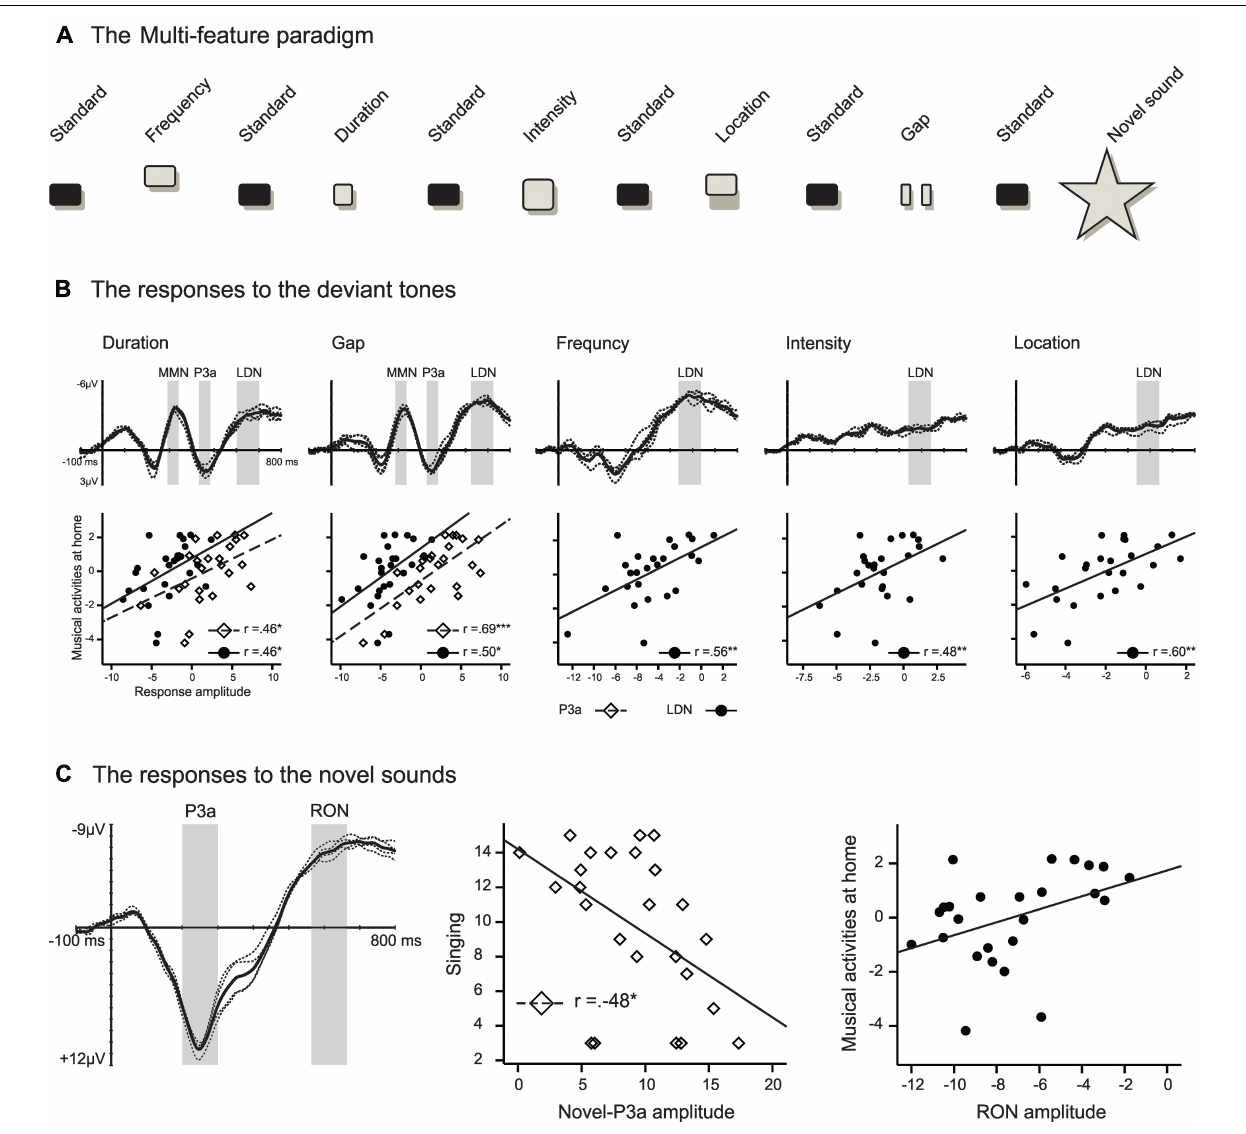
amplitudes and informal everyday musical activities. In the ERP figures, the thin dashed lines represent the difference signal at individual fronto-central channels and the thick solid line is the average of these signals.The gray bars indicate the latency windows that were used to calculate the response mean amplitudes. Panels (B) and (C) reproduced with permission from Putkinen etal.